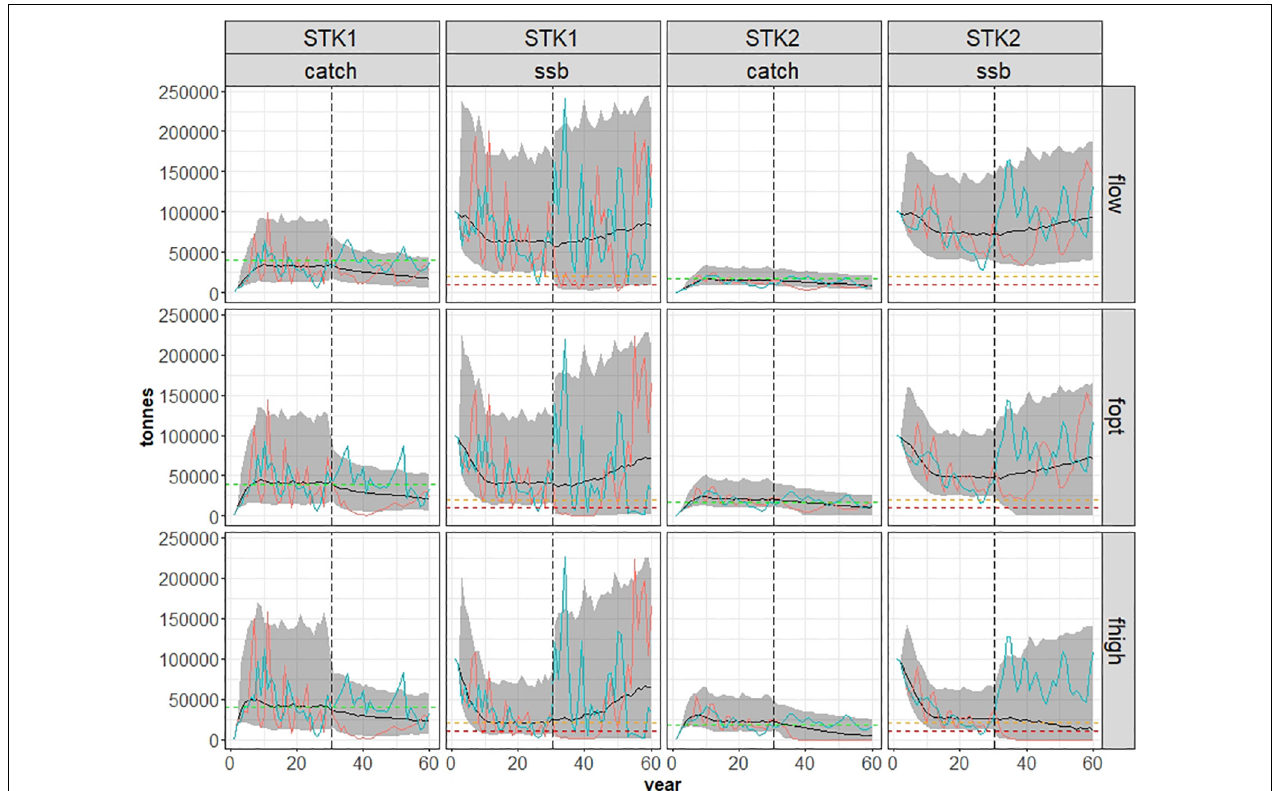
FIGURE 4 | Trajectories of catch and SSB in tonnes along years (x-axis) for the 2-over-3 rule with a 20% uncertainty cap and under an in-year advice for different life histories: stock-types in columns and historical exploitation levels in rows. The solid line represents the median and the shaded area the 90% confidence intervals computed from the 5th and 95th percentiles and coloured lines represent specific iterations. The dashed vertical line is located before year 31, which is the first year of the projection. The dashed horizontal lines represent the different reference points: the green line in catch plots correspond to MSY and orange and red lines in SSB plots to B lim (20% B 0 ) and B collapse (10% B 0 ), respectively. Interactive version of the figure is available online at